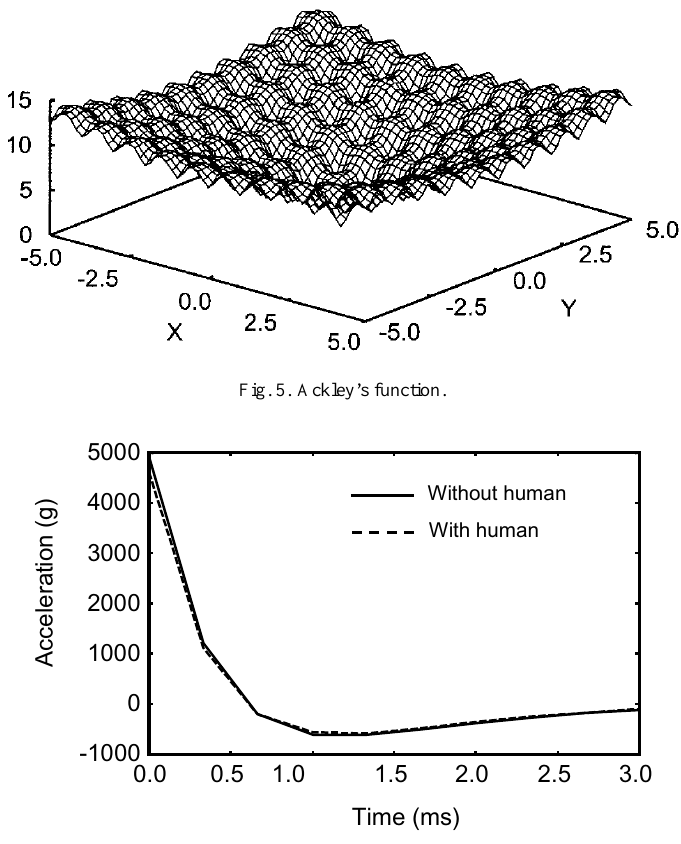
Fig. 5. Ackley’s function.